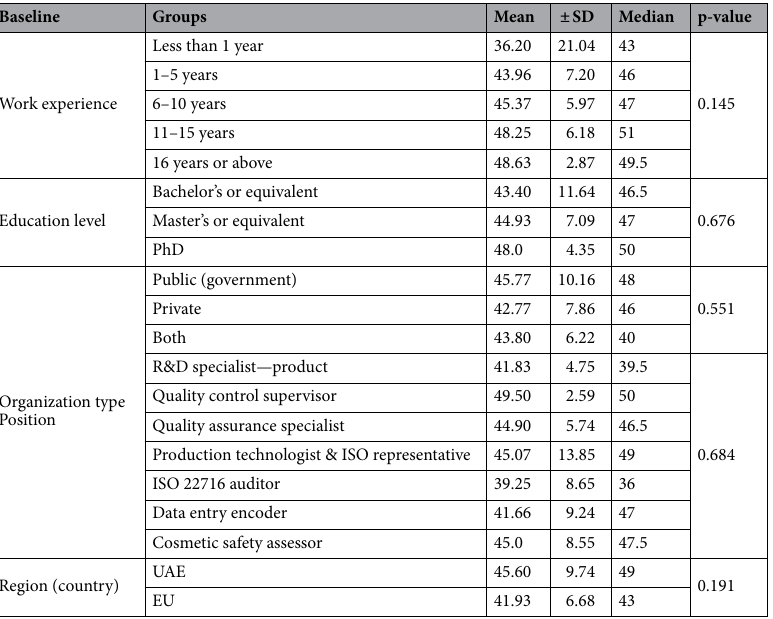
Table 4. Overall agreement rate stratified by experts’ baseline characteristics. R&D Research and Development, UAE United Arab Emirates, EU European Union.